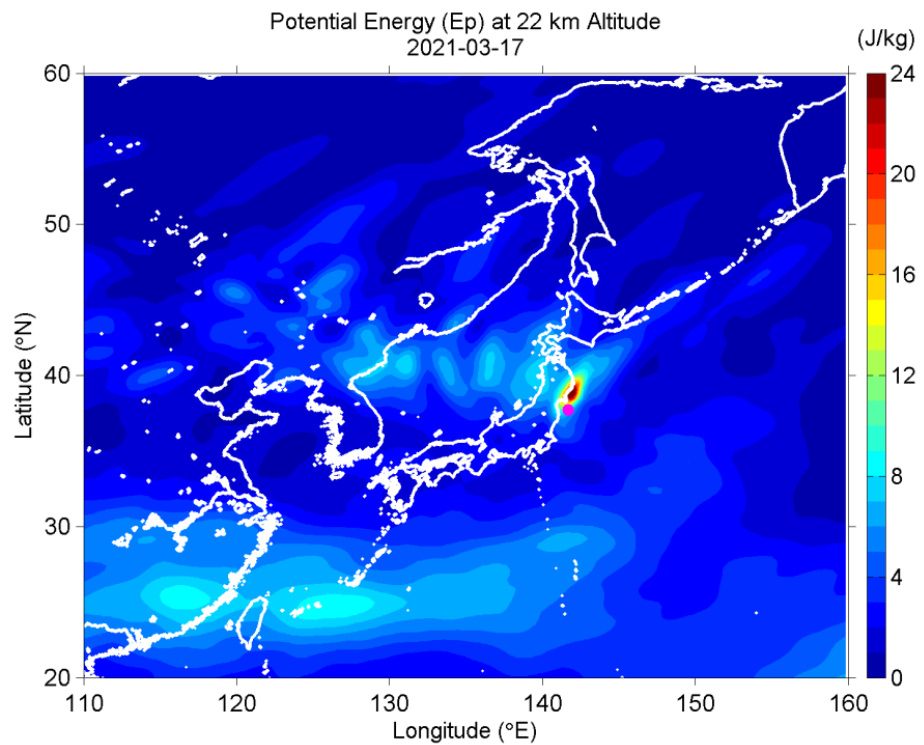
Figure 12. Same as in Figure 9, but for the second March EQ at a specific altitude of 22 km on 16 March. The color scaling is also different from that in Figure 9.